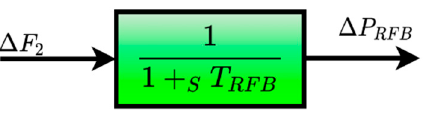
Figure 7. Transfer function of RFB.